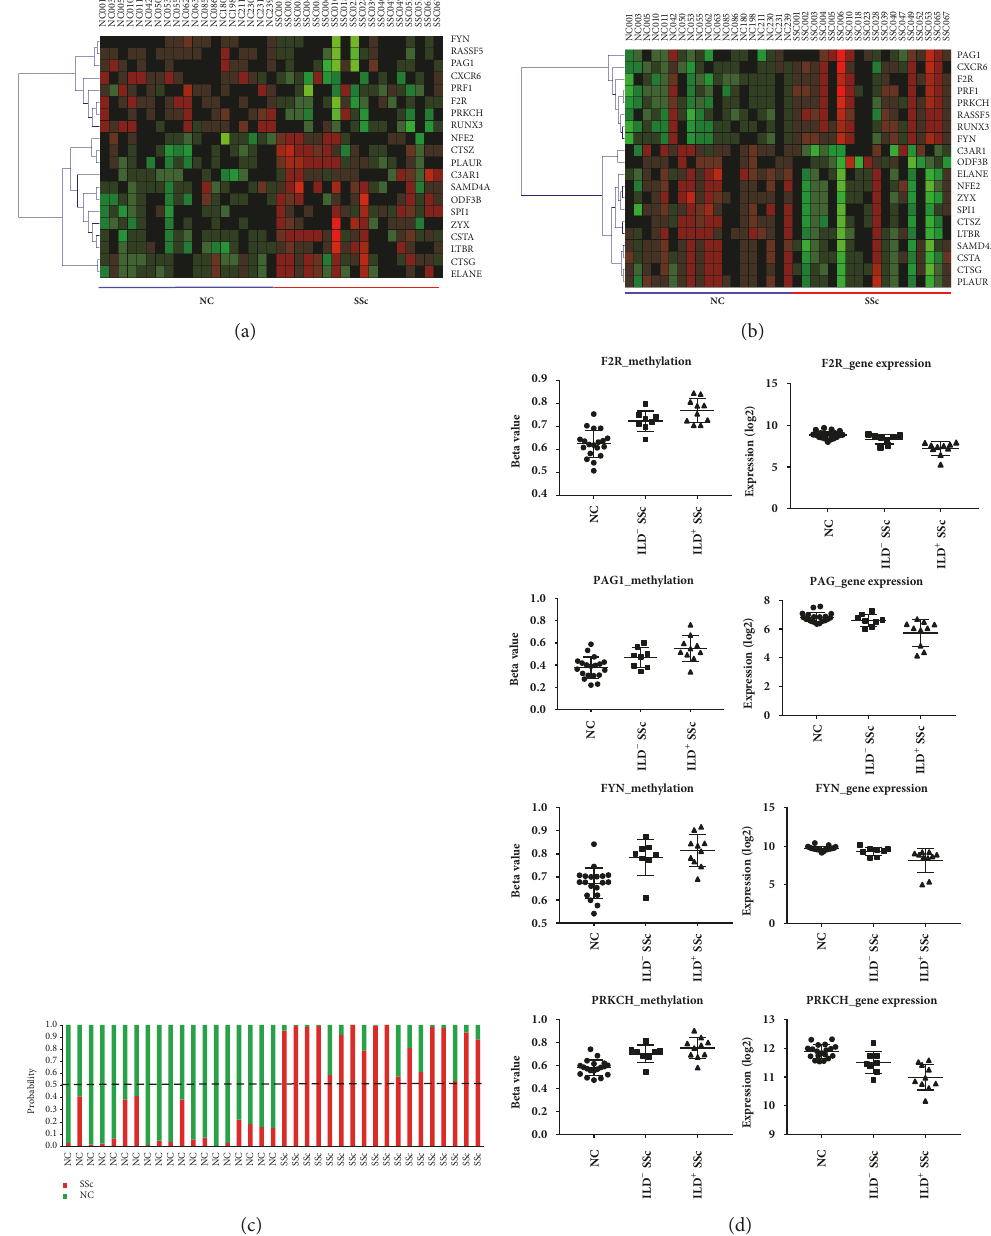
Figure 5: Association of clinical characteristics of SS c and 20 D EGs. (a) Heatmaps of gene expression and (b) DNA methylation show the most significant 20 correlated genes for SSc versus Normal. (c) Support vector machines analysis. The y-axis shows the group proportion inferred by SVM and sample ID is on the x-axis. (d) Array-based DNA methylation and mRNA expression among normal controls, the SSc with ILD, and SSc without ILD group, p -value < 0.05 between SSc with and without ILD groups, are